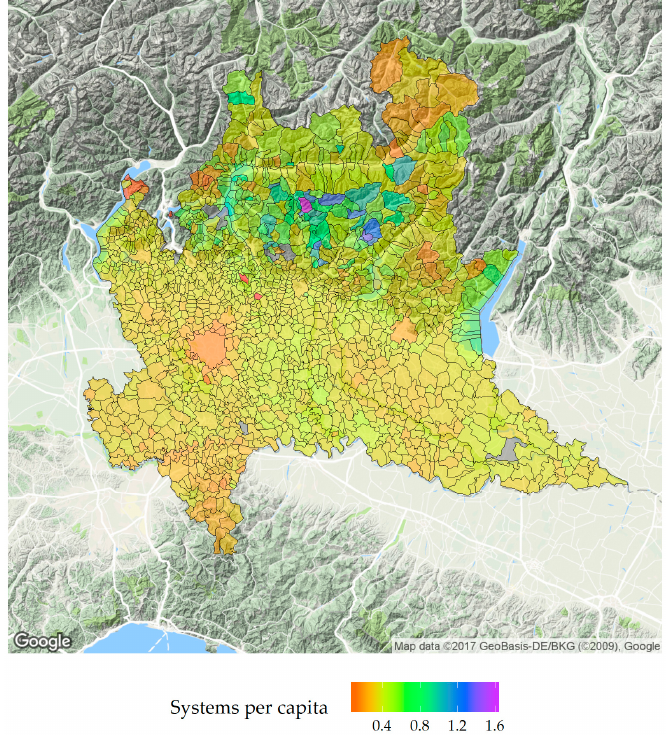
Figure 2. Number of systems per capita in each municipality.